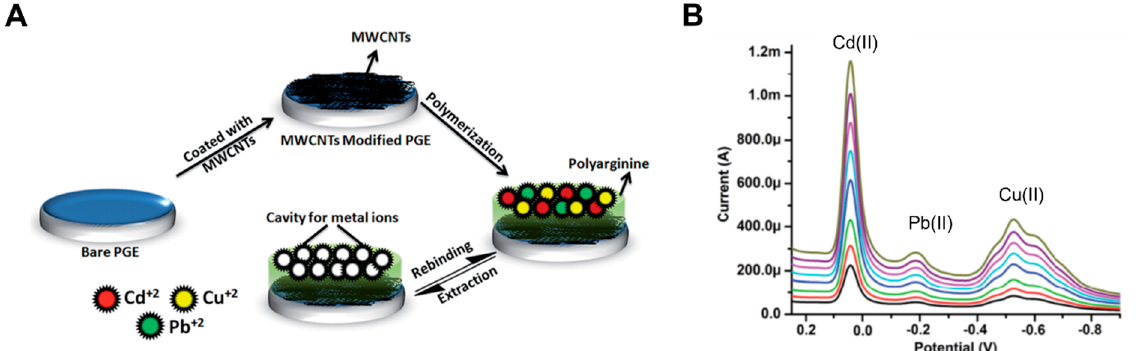
Figure 5. ( A ) Schematic representation showing the production of an imprinted nanowire modified pencil graphite electrode (PGE). ( B ) Differential pulse stripping voltammograms for the simultaneous detection of cadmium(II), lead(II), and copper(II) at different concentrations. Figure reproduced and modified from [100] with permission from copyright The Royal Society of Chemistry 2014.